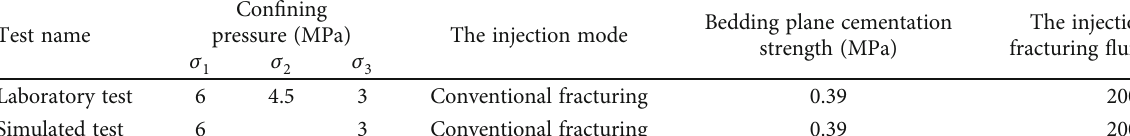
Table 3: Experimental